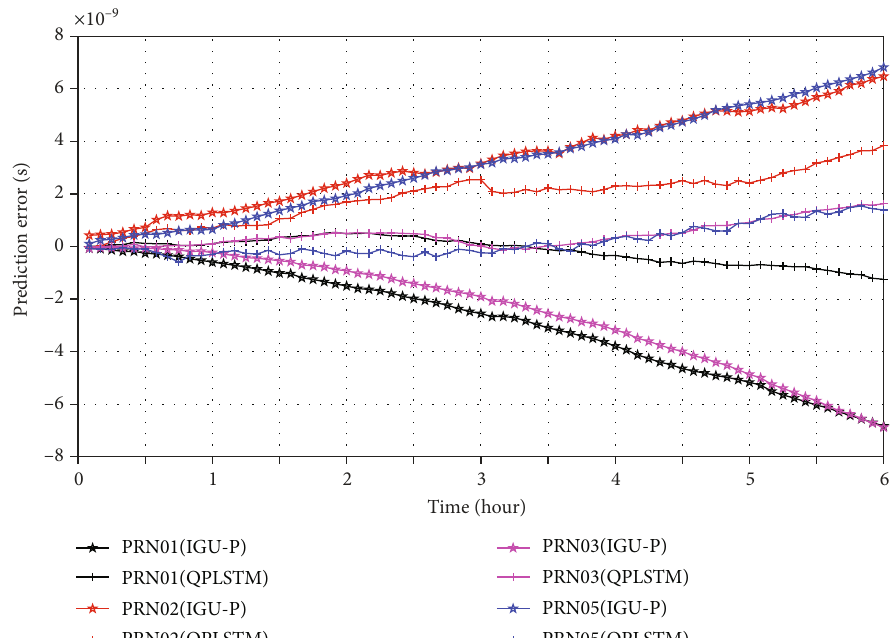
Figure 7: Prediction residuals for IGU-P and QPLSTM for Figure 9 represents the prediction accuracy of the clock o ff - set for the selected 15 BDS satellites of the fi ve models for two durations. It can be seen that each of LP, QP, GM (1,1), and ARIMA model cannot make the RMS lower than 0.3 ns in 1 h forecasting for every type of satellites.